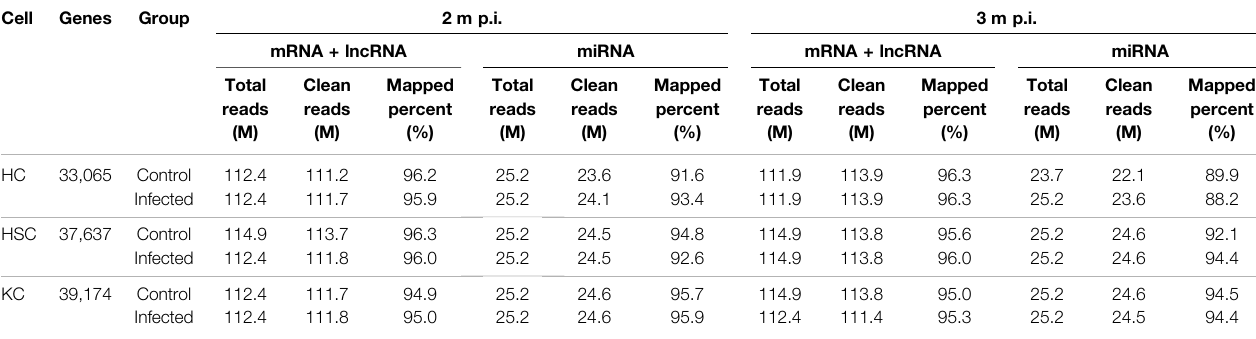
TABLE 1 | The statistics of sequencing